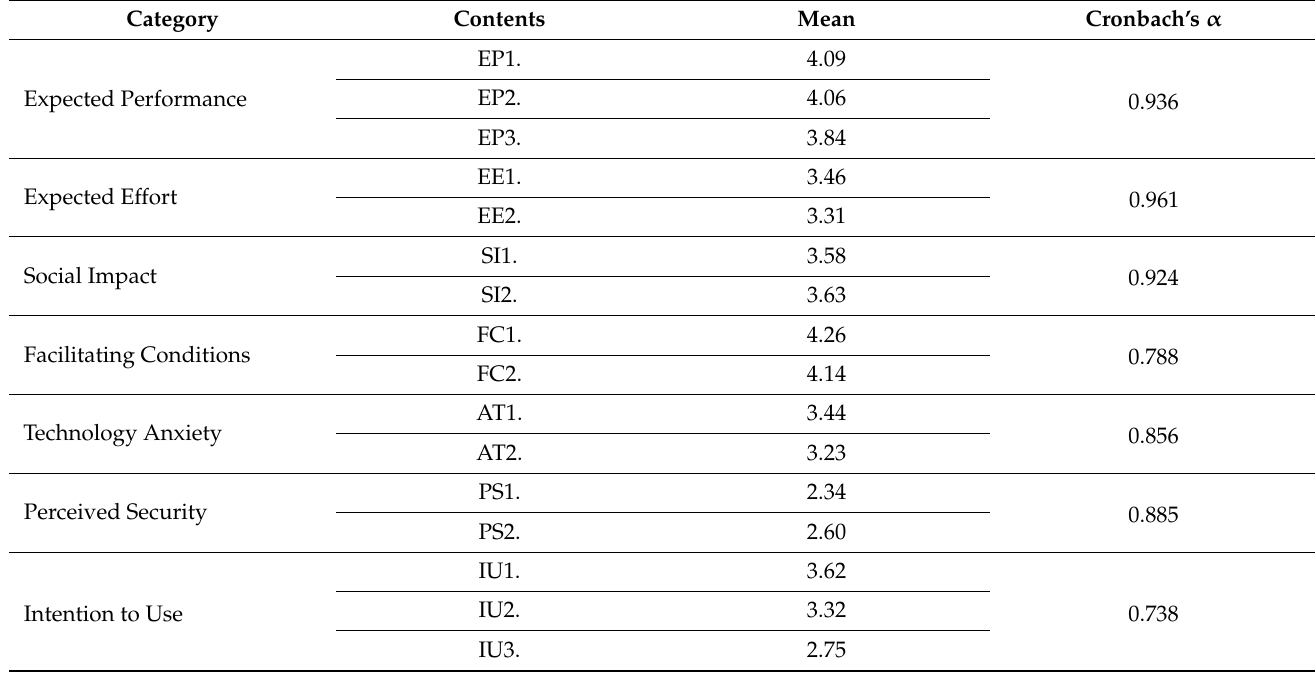
Table 10. Smart Home Technology